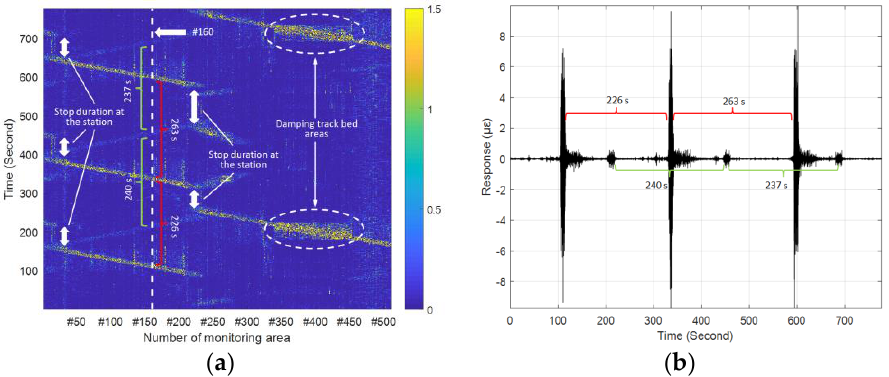
7 of 14 Figure 5. Simulated human intrusion scenarios along the rail track in the selected tunnel area. 4. Results and Discussion This section reports the characteristics of distributed vibration responses under operating train and simulated incursion conditions, respectively. Feasibility, based on the proposed comprehensive approach concerning train tracking and detecting incursion, was investigated and is discussed. All the following analyses were based on the original output of the distributed vibration responses with no additional techniques adopted to improve the data quality. 4.1. Distributed Vibration Responses under Load of Passing Train Figure 6a depicts a typical visualization relationship between the structural vibration intensity and the space and time. Here, the vibration intensity was represented by color of the figure. A waterfall diagram such as Figure 6a can be used to help analyze the train’s running direction, speed change and arrival or departure interval. In the tunnel where the sensing optic fiber arrays were deployed, the train entered the experimental area from #500 monitoring zone in Figure 6a. In this case, a moving train appeared as a diagonal signal pattern where the slope depended on the speed. Here, the diagonal signal pattern highlighted the characteristics of the distributed vibration response caused by the passing train within the monitoring range. Three complete sets of such diagonal signal patterns can be clearly seen in the left part of Figure 6a. Moreover, vibrations generated by moving trains in the opposite direction in the adjacent tunnel were simultaneously detected by the sensing optic fiber, although the vibration intensity was somewhat weak. Further, the process of the train stopping at the station between the diagonal signal patterns can also be observed in the figure. For